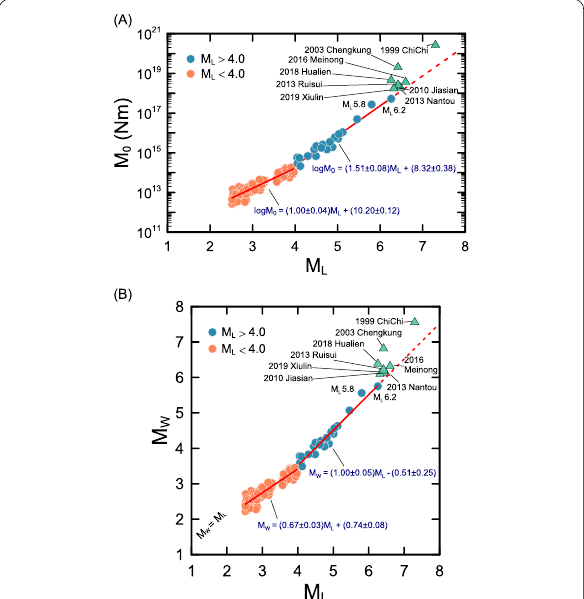
Fig. 6 The plots of A M 0 vs. M L and B M W vs. M L . Also shown are several moderate and large Taiwan earthquakes whose M 0 and M W are from the U.S. Geological Survey (USGS). A crossover magnitude appears at M L 4.0, which divides the M 0 –M L and M W –M L relations = into two parts. The relations indicate that M L likely saturates for M L >